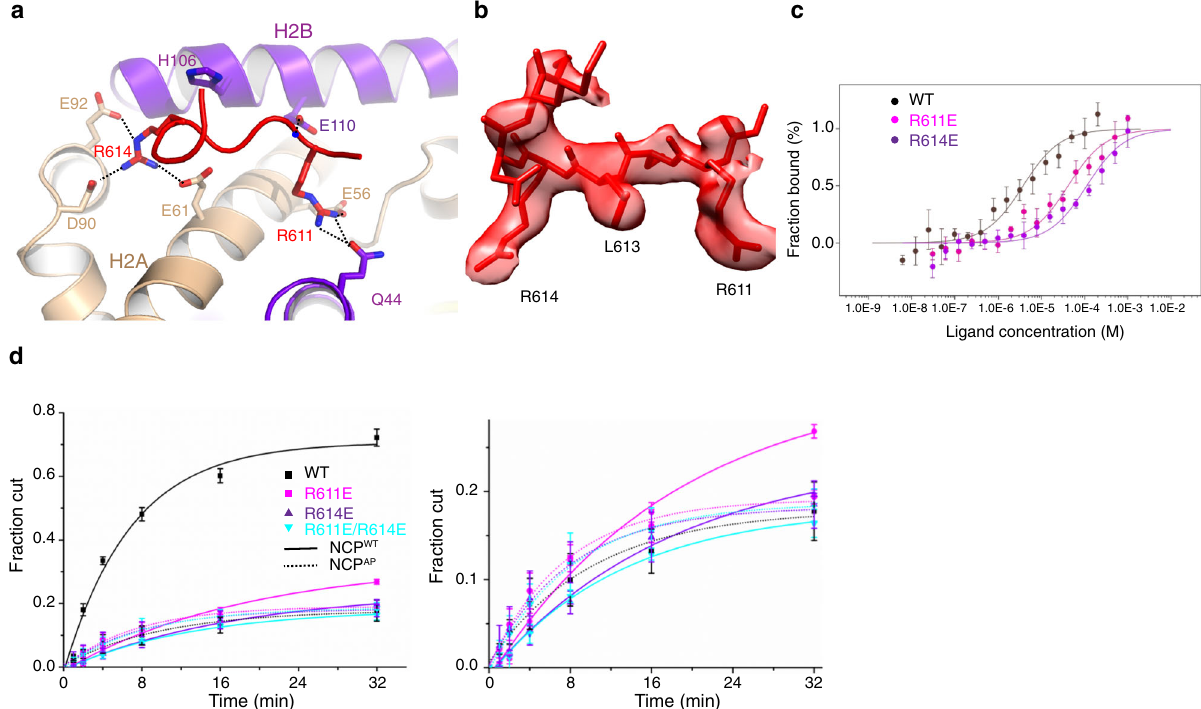
Fig. 4 Binding of the linker region of ALC1 to the acidic patch of the nucleosome. a Structure of the linker region of ALC1 bound to the acidic patch of the nucleosome. b Local cryoEM density around the linker region of ALC1. c MST measurements of the H2A-H2B binding af fi nities of the WT and mutant ALC1 peptides (residues 604 – 623). Error bars indicate standard deviations for three independent measurements and the measure of center for the error bars is the mean value. d Chromatin remodeling activities of WT and three mutant ALC1 toward the intact nucleosome (NCP WT ) and acidic patch mutant nucleosome (NCP AP , dotted lines). Error bars indicate standard deviations for three independent measurements and the measure of center for the error bars is the mean value. The activities of the mutants are enlarged and shown on the